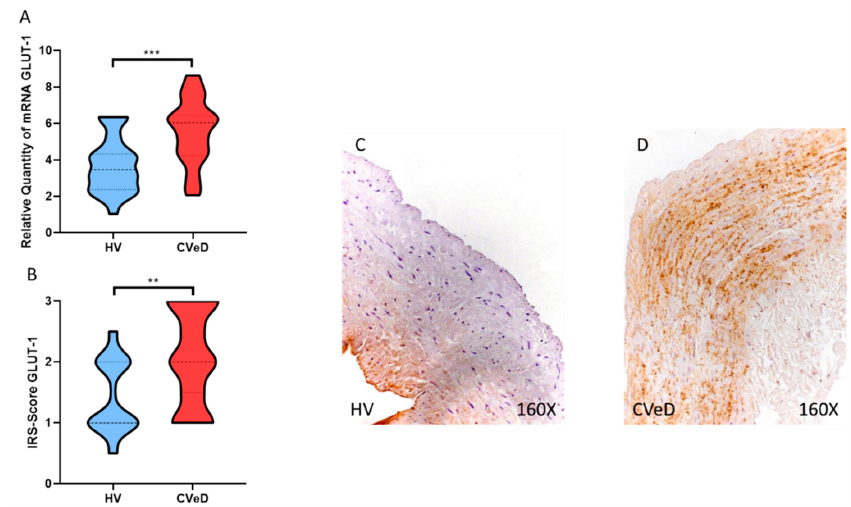
Figure 1. ( A ). GLUT-1 mRNA expression in the HV group (Healthy controls) and CVeD patients (chronic venous disorder). ( B ). IRS-Scores for GLUT-1 in the venous wall of the HV group and the CVeD group. ( C – D ). Images showing the immunostaining for GLUT-1 in the C group in the three tunicae of the venous wall. p < 0.01 (**) and p < 0.001 (***).